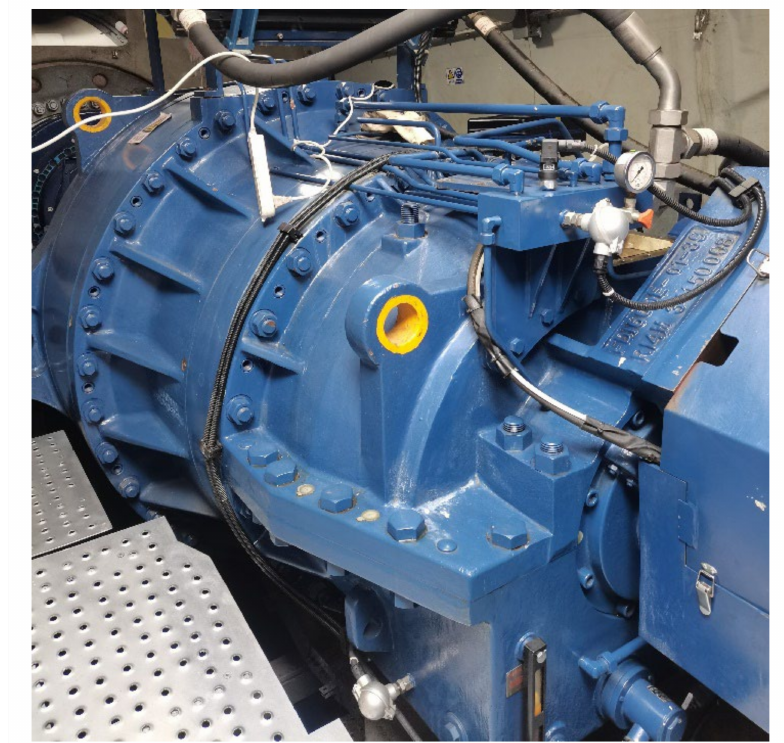
Figure 3. Planetary gearbox in the case